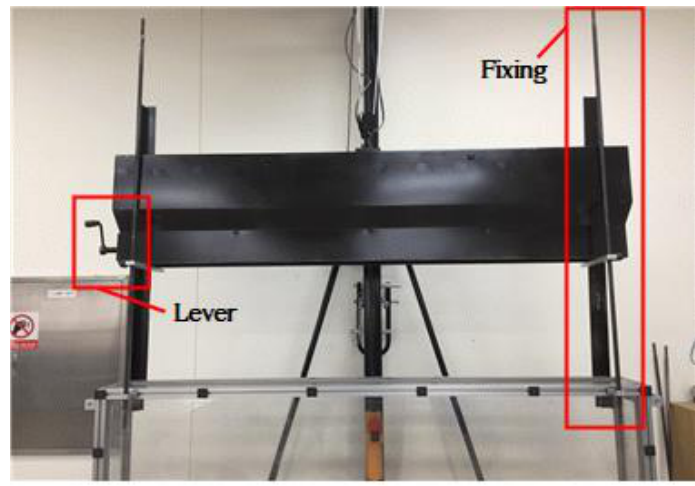
Figure 4. Sand-pouring device.